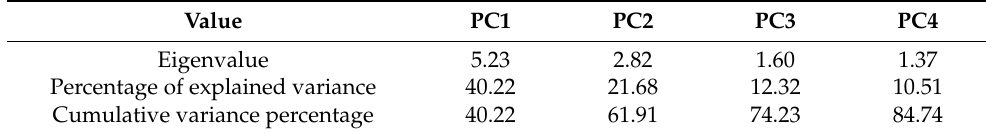
Table 9. Eigenvalue and percentage of variances retained by principal components that describe the resistance mechanisms of the eleven races of maize to Tetranychus merganser at 72 h under laboratory